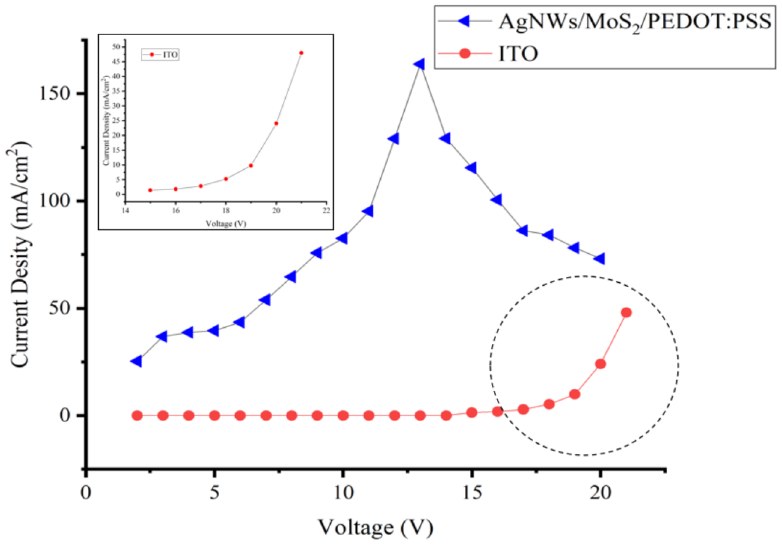
Figure 10. Voltage current density curve of OLED device. The upper left figure shows the circle marking area.